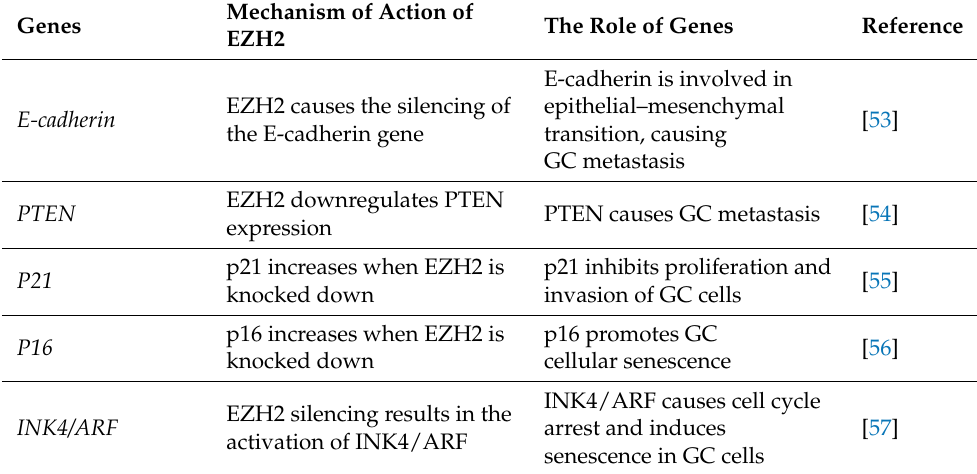
Table 3. The genes related to EZH2 and gastric carcinogenesis. Mechanism of Action of Genes